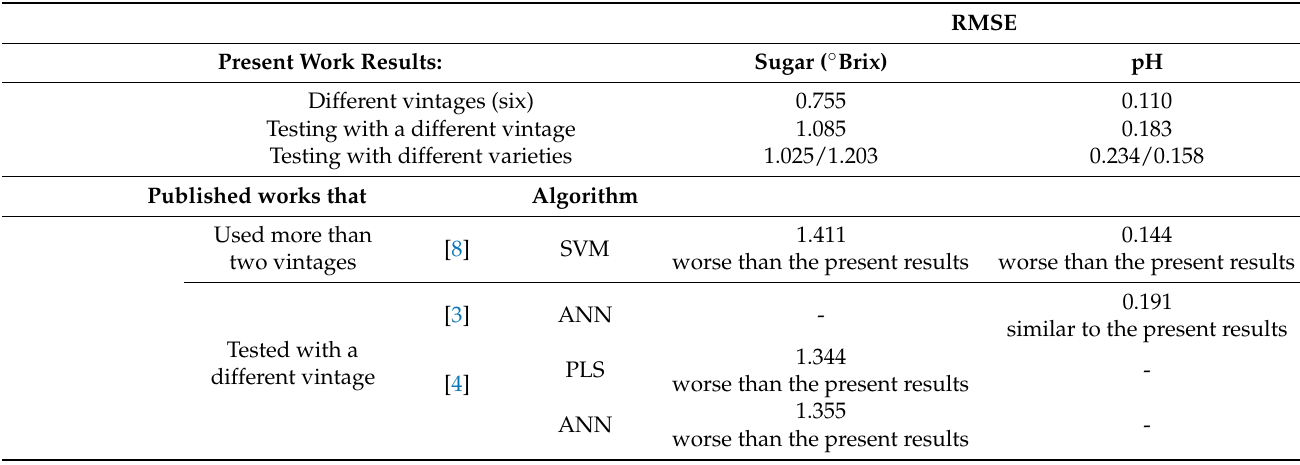
Figure A3. Absolute errors obtained for the independent test set comprising TF (blue point), TB (orange points), and TN (green points) varieties in ( a ) sugar measurements and ( b ) pH measurements. Table A1. Comparison of results from the present work and from other works published in the literature for the prediction of sugar content and pH using spectroscopic techniques in reflectance mode.